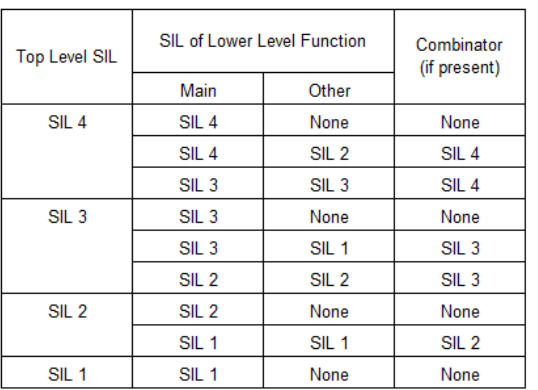
Table 3. Apportionment of safety integrity